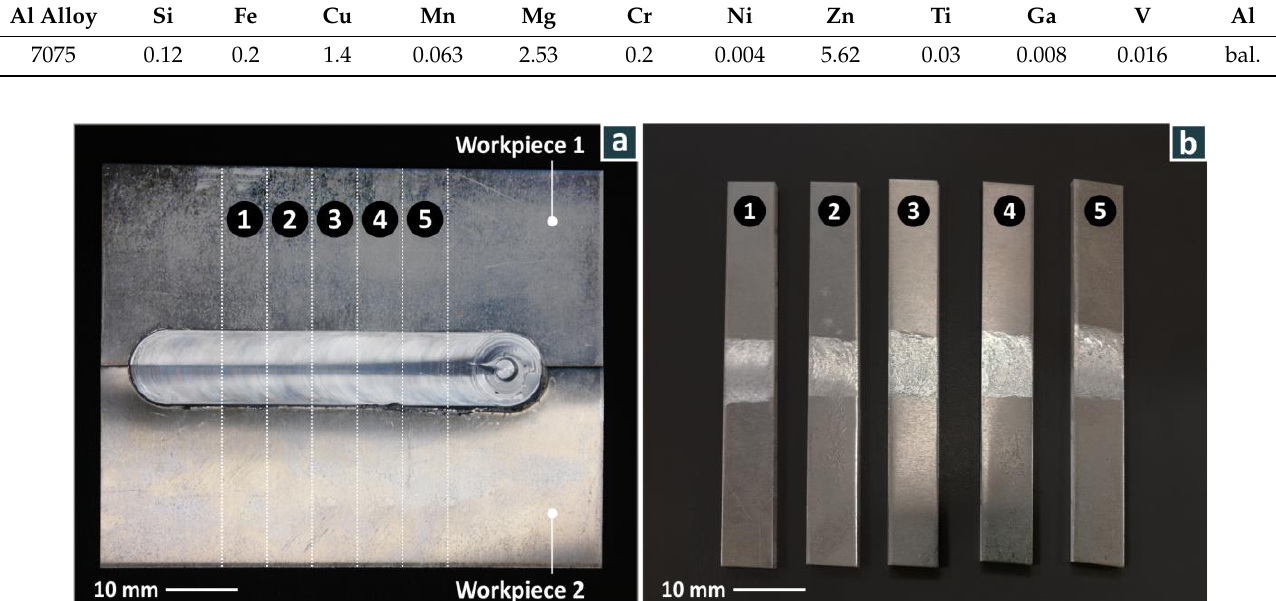
Figure 3. Five different welding tools: designs ( a , c , e , g , i ) and products ( b , d , f , h , j ). Table 3. Chemical composition (wt.%) of 7075 aluminum alloy.